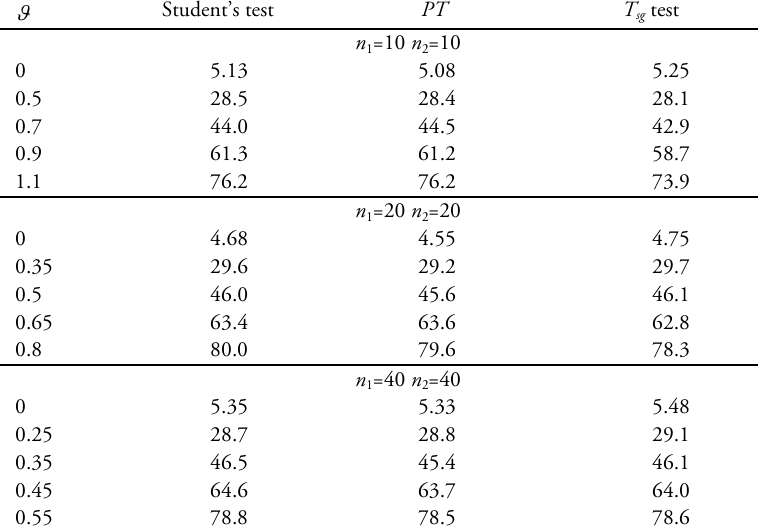
Power estimates in percent for the t test, PT and the proposed test at (cid:68) =5% and for two samples of equal